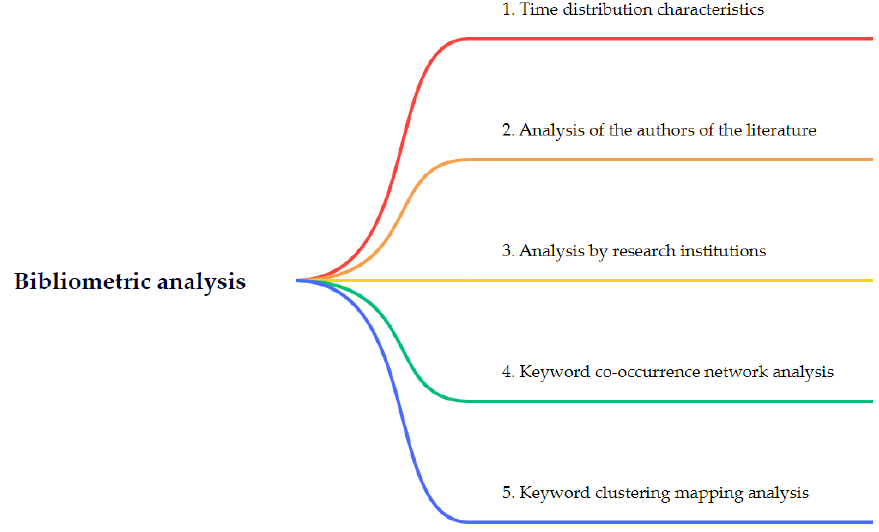
Figure 2. Five parts of the analysis in the bibliometric section. Data Source.